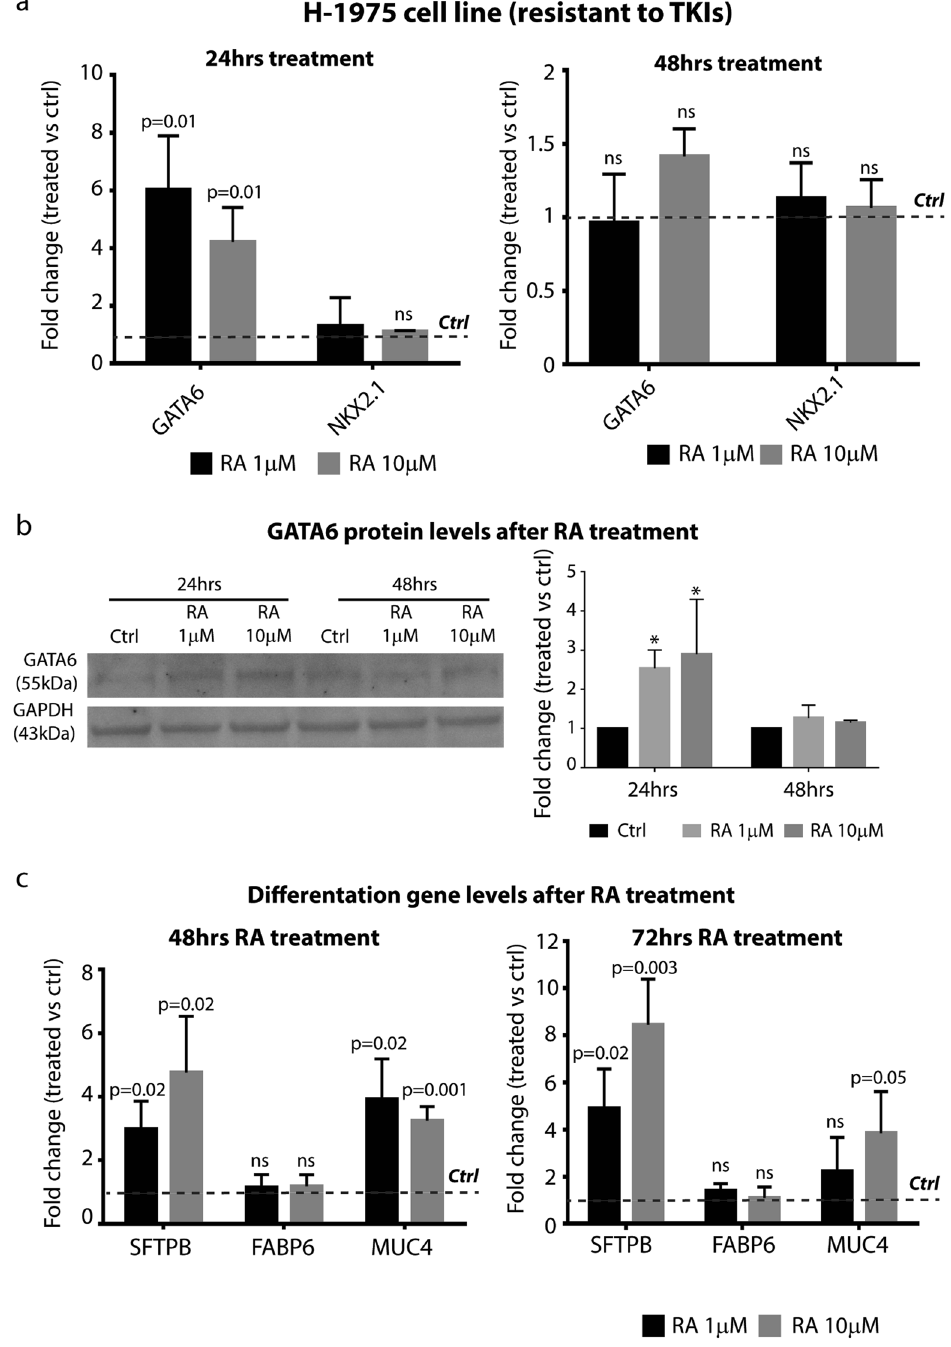
Figure 2. RA treatment induces TKI resistant NSCLC cell differentiation. (a) qRT-PCR analysis of GATA6 and NKX2.1 in H-1975 NSCLC cell line treated with 1 and 10 µ M RA for 24 and 48 hrs. The comparison has been conducted by using the ΔΔ CT method and normalized to GAPDH transcript. Dotted line represents the normalized expression levels of each transcript analyzed in untreated cells. Data are represented as mean ± SD. Statistical analysis has been obtained by paired t test (n = 3). (b) Left panel, Representative Western blotting analysis of GATA6 and GAPDH in H-1975 cells treated with 1 and 10 µ M RA for 24 and 48 hrs. Right panel, densitometric analysis of GATA6 levels, normalized versus GAPDH, used as loading control (n = 4) ( * = 0.02). (c) qRT-PCR analysis of GATA6 target genes in H-1975 NSCLC cells treated with 1 and 10 µ M RA for 48 and 72 hrs. The comparison has been conducted by using the ΔΔ CT method and normalized to GAPDH transcript. Dotted line represents the normalized expression levels of each transcript analyzed in untreated cells. Data are represented as mean ± SD. Statistical analysis has been obtained by unpaired t test (n =